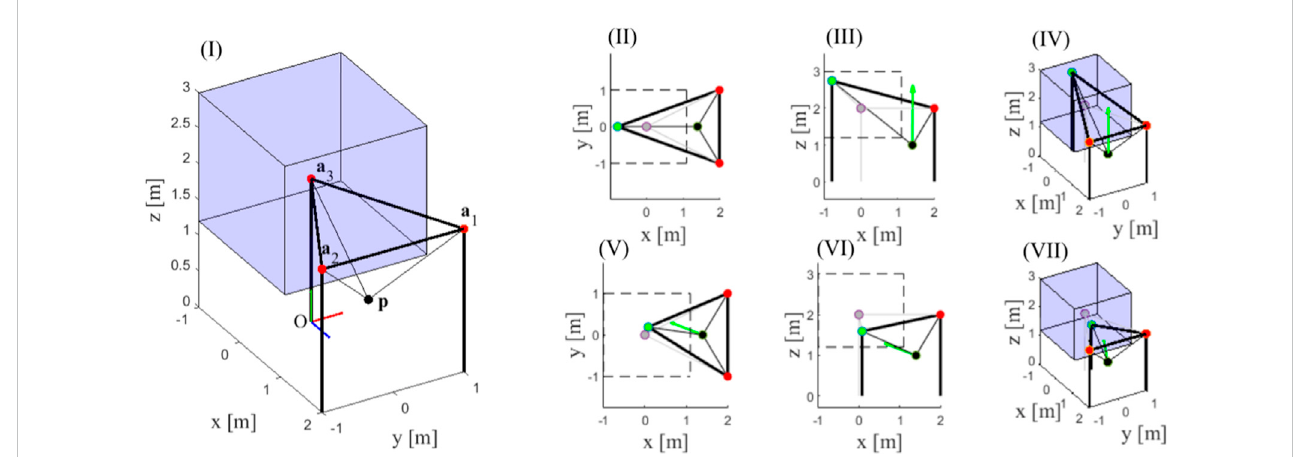
FIGURE 1 Nominal con fi guration of the TR-CSPR and optimal position of the recon fi gurable exit-point for two different choices of the direction d of interest.